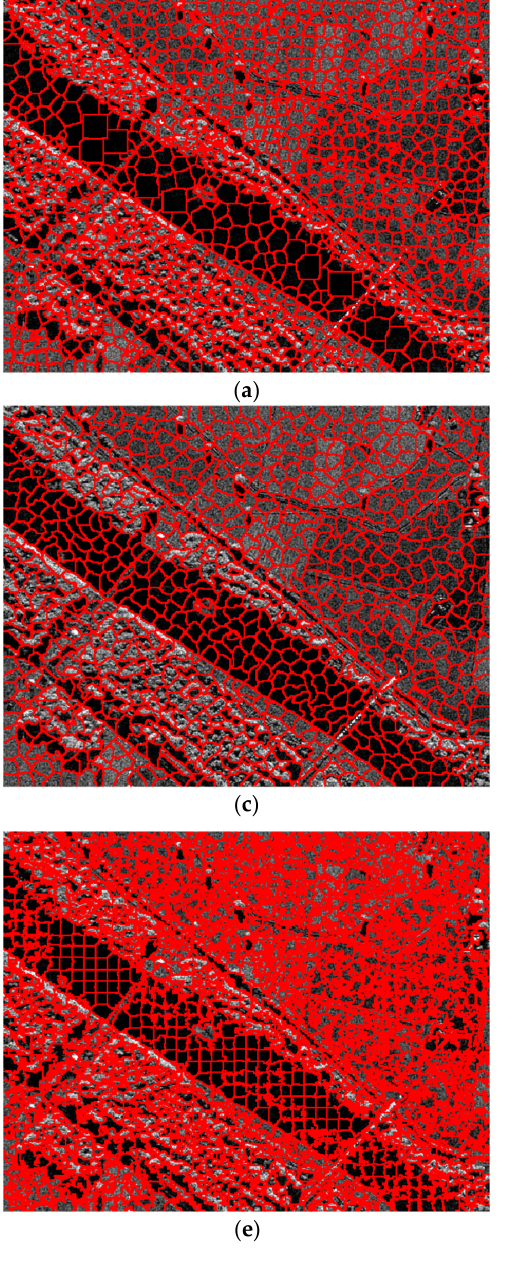
Figure 19. Superpixel generation results for the real SAR image SI 5 . ( a ) SLIC, ( b ) SNIC, ( c ) SEEDS, ( d ) SPAMP, ( e ) CAS, and ( f ) EDTRS.